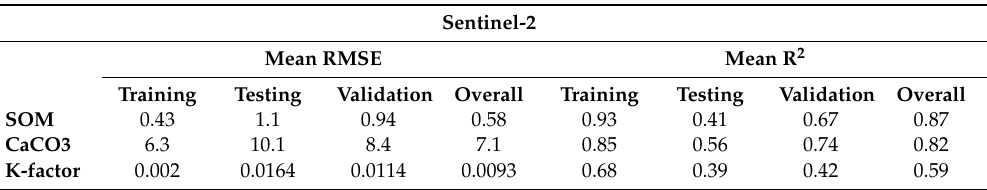
Table 4. Statistics of R 2 and RMSE concerning the performance of the MPL ANN algorithm in the Sentinel-2 data.